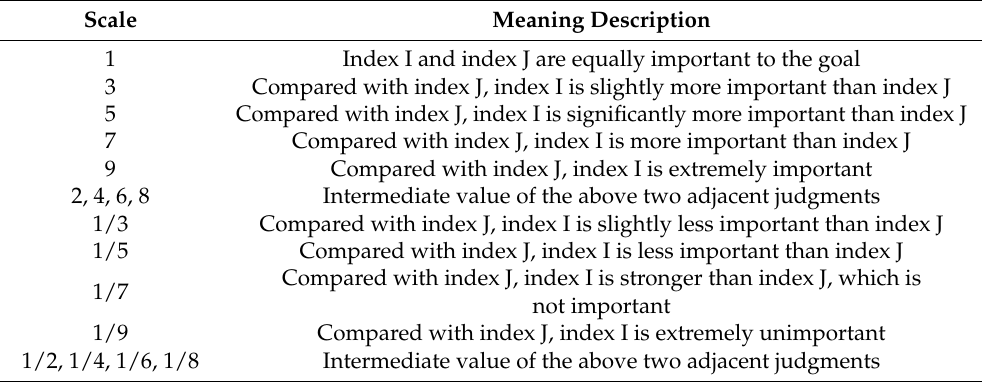
Table 1. Saaty scale of the analytic hierarchy process.